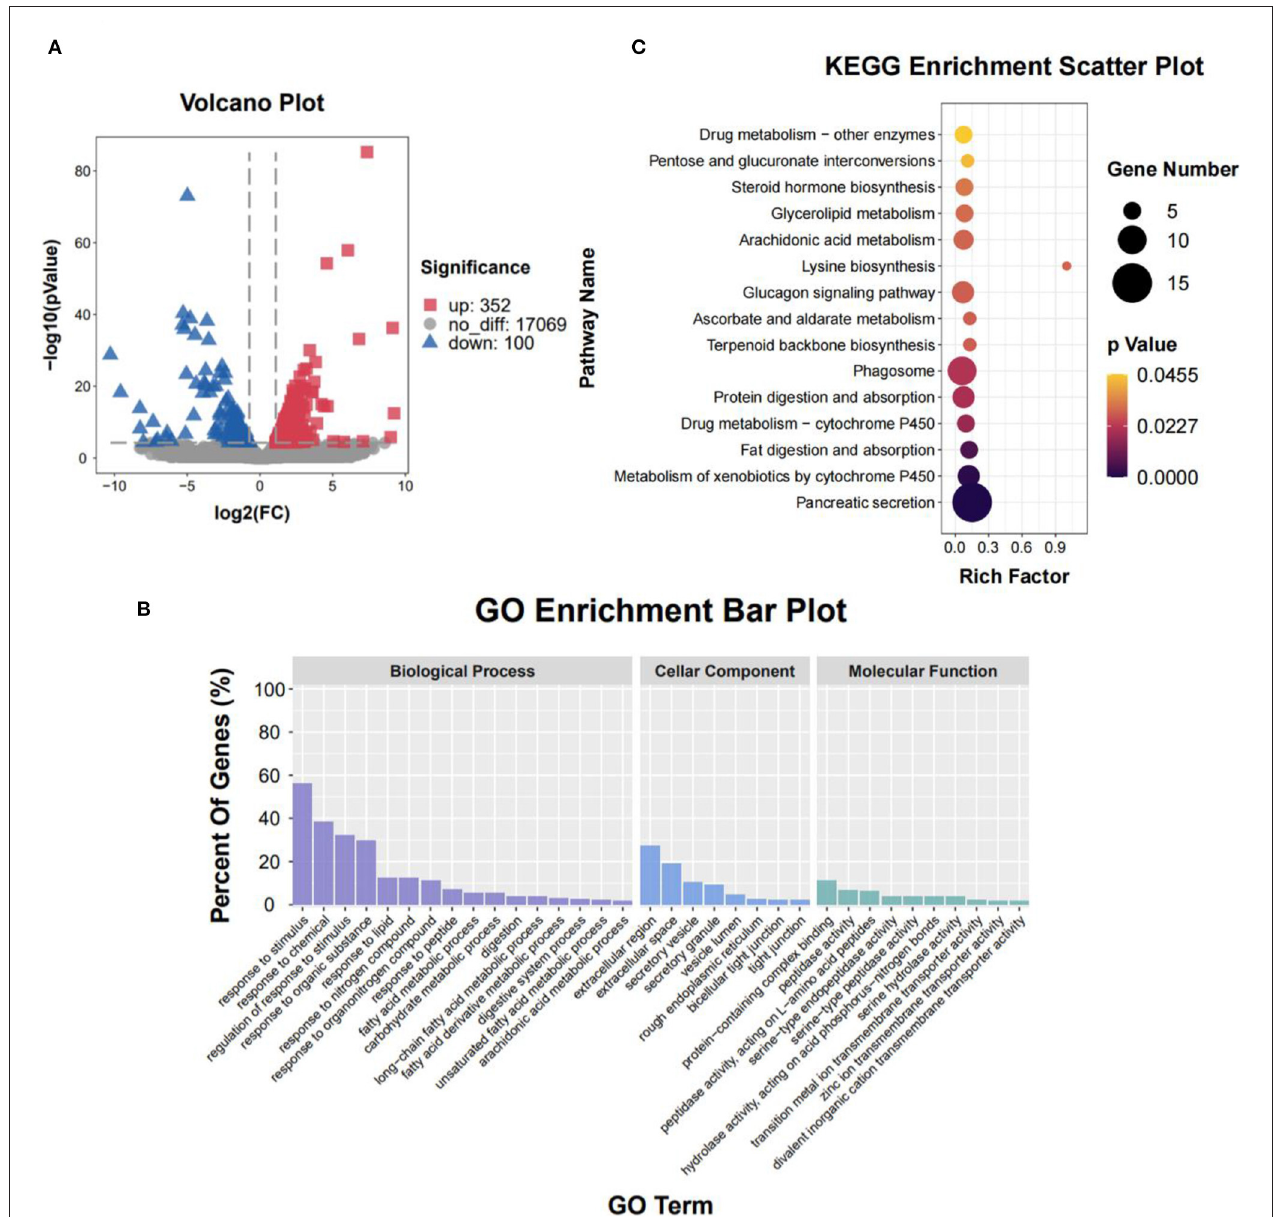
FIGURE 2 | Liver transcriptome of the CON and SPH groups. (A) Volcano plot of distribution trends for differential expression genes (DEGs). Down-regulation and up-regulation are presented with blue and red dots, respectively ( n = 3). (B) Gene ontology (GO) pathway enrichment analysis of DEGs. Each annotated sequence is divided into at least one GO term of the following: biological process, cellular component or molecular function. (C) Kyoto Encyclopedia of Genes and Genomes (KEGG) pathway enrichment analysis of DEGs. The size of the circles indicates the number of genes enriched in the pathway, and its color indicates the P